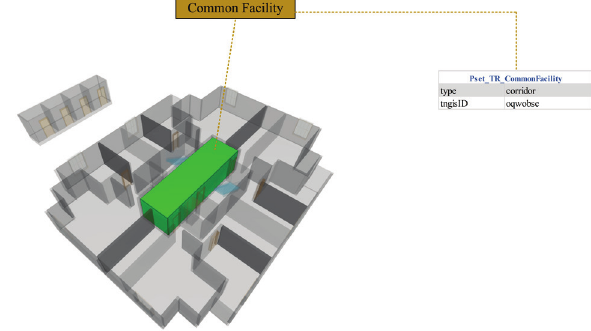
Figure 7. Modelled corridor as a common